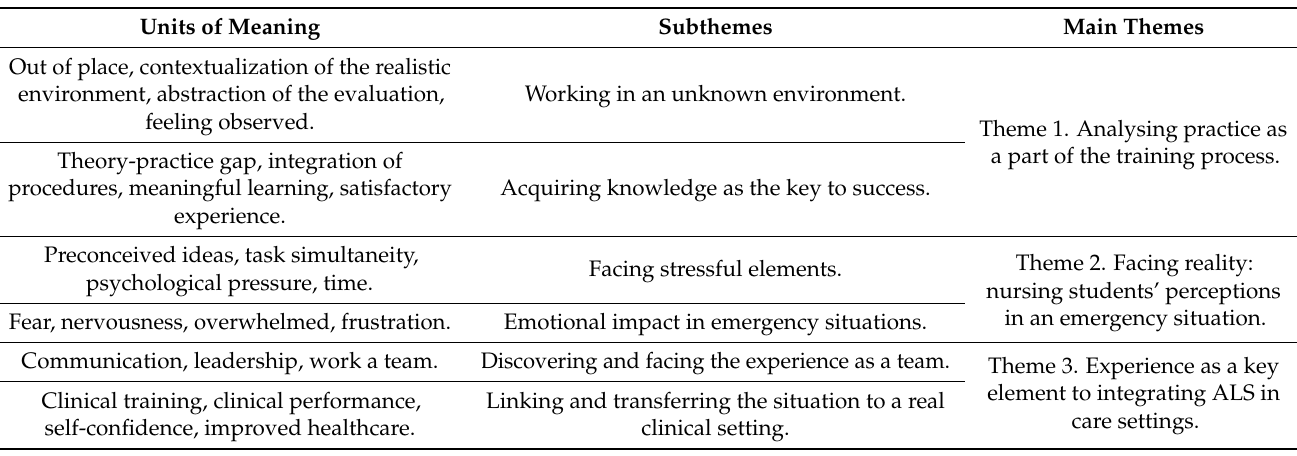
Table 3. Units of meaning, subthemes and main themes of the analysis. Units of Meaning